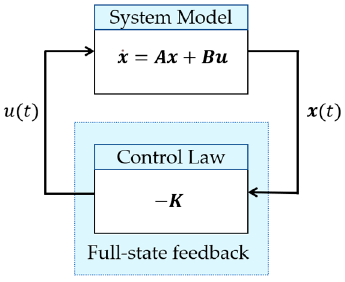
Figure 6. Full State Feedback